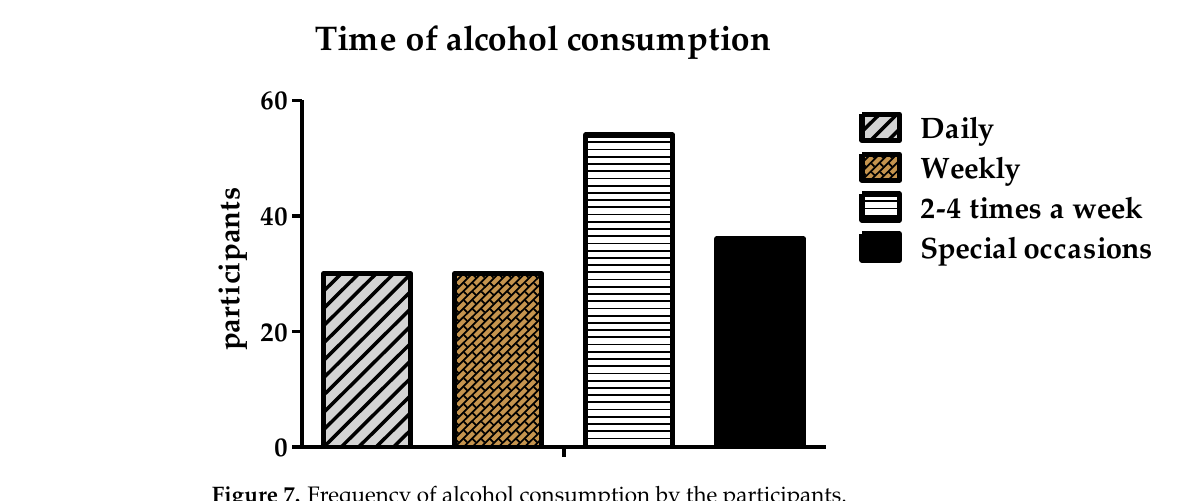
Figure 7. Frequency of alcohol consumption by the participants.